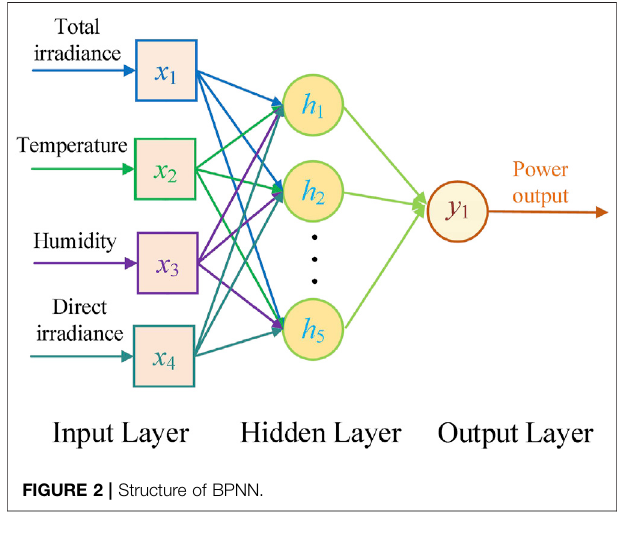
FIGURE 2 | Structure of